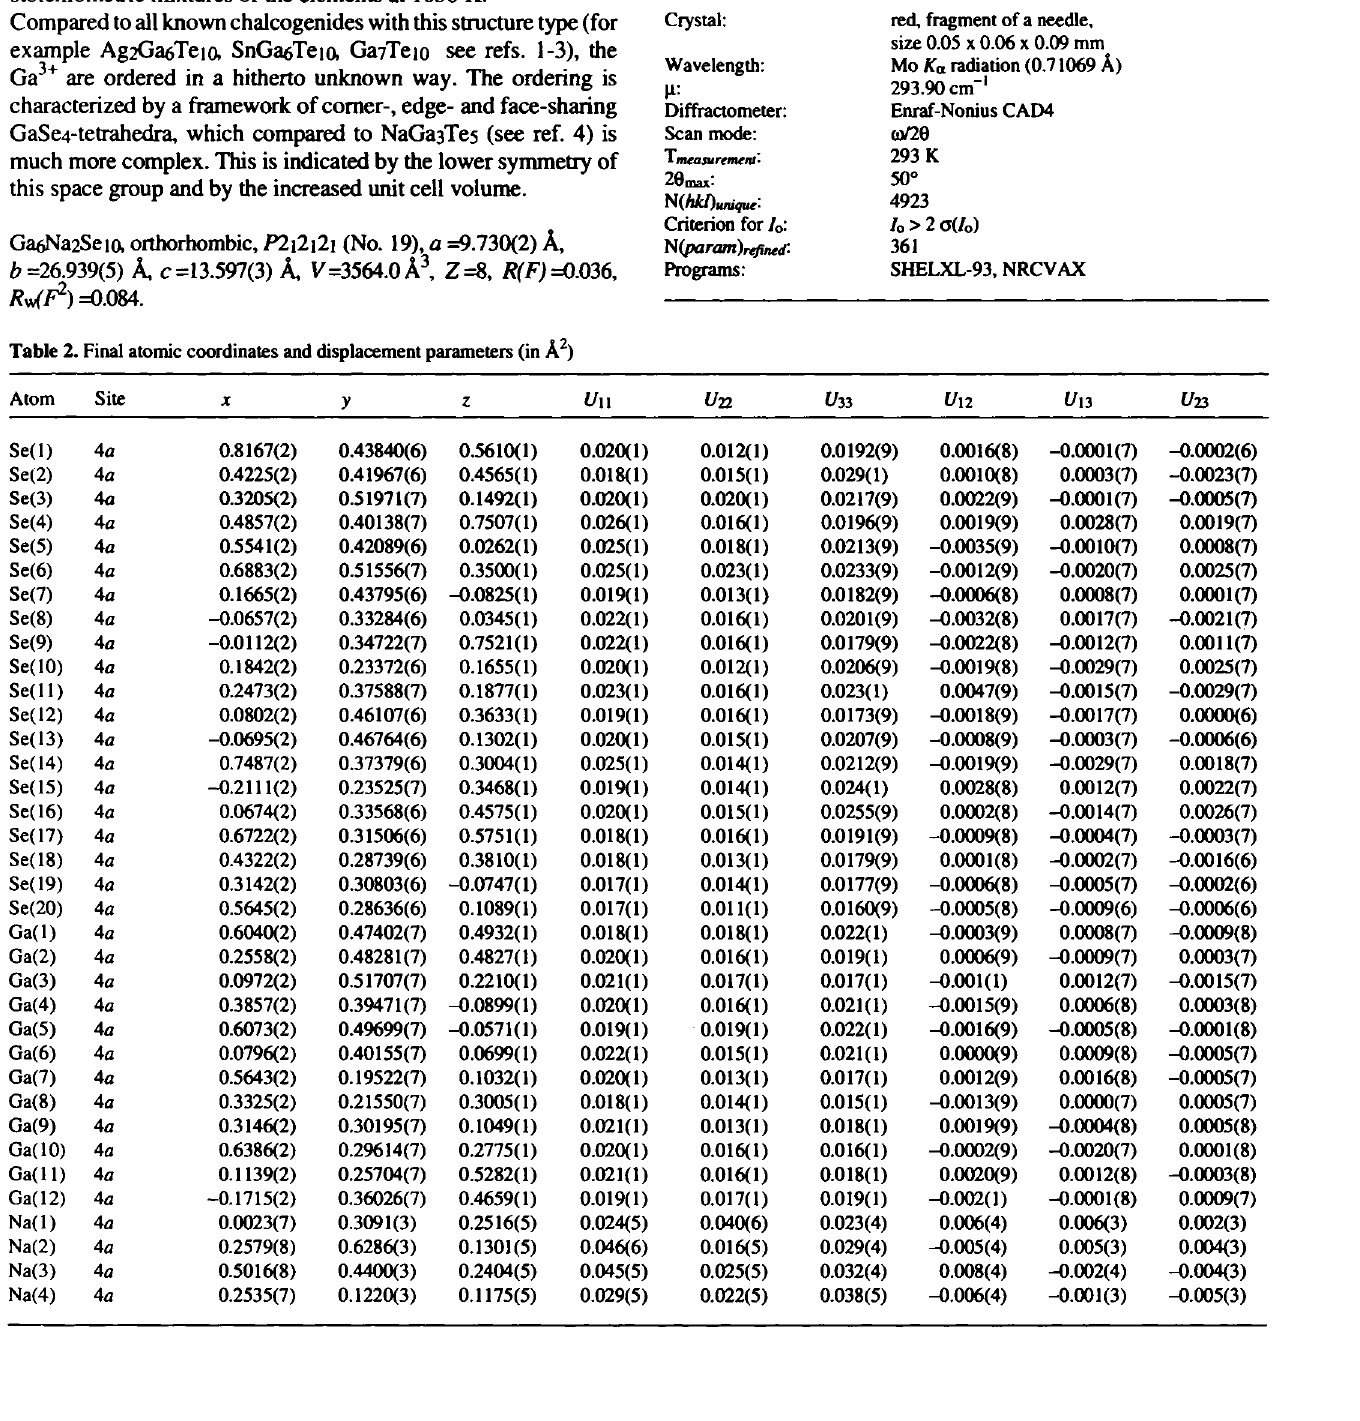
Table 2. Final atomic coordinates and displacement parameters (in Â^)